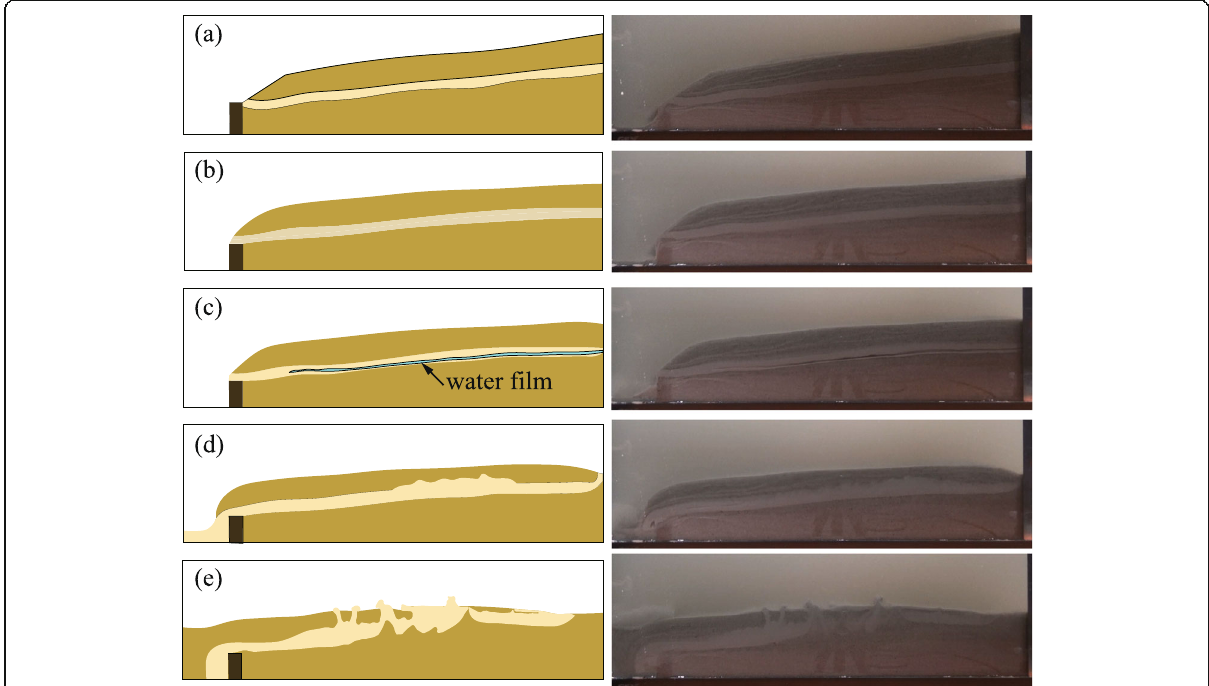
Fig. 4 Three-layer sandbox test; frontal view in illustration (left) and actual image (right) at different stages: a Before excitation, b during liquefaction, c during water film formation, d beginning of lateral movement, and e after large mass movement with sand boiling. In the illustration, brown represents the vertical plate, while dark and light yellow represent coarse and fine sand, respectively. Blue represents a water